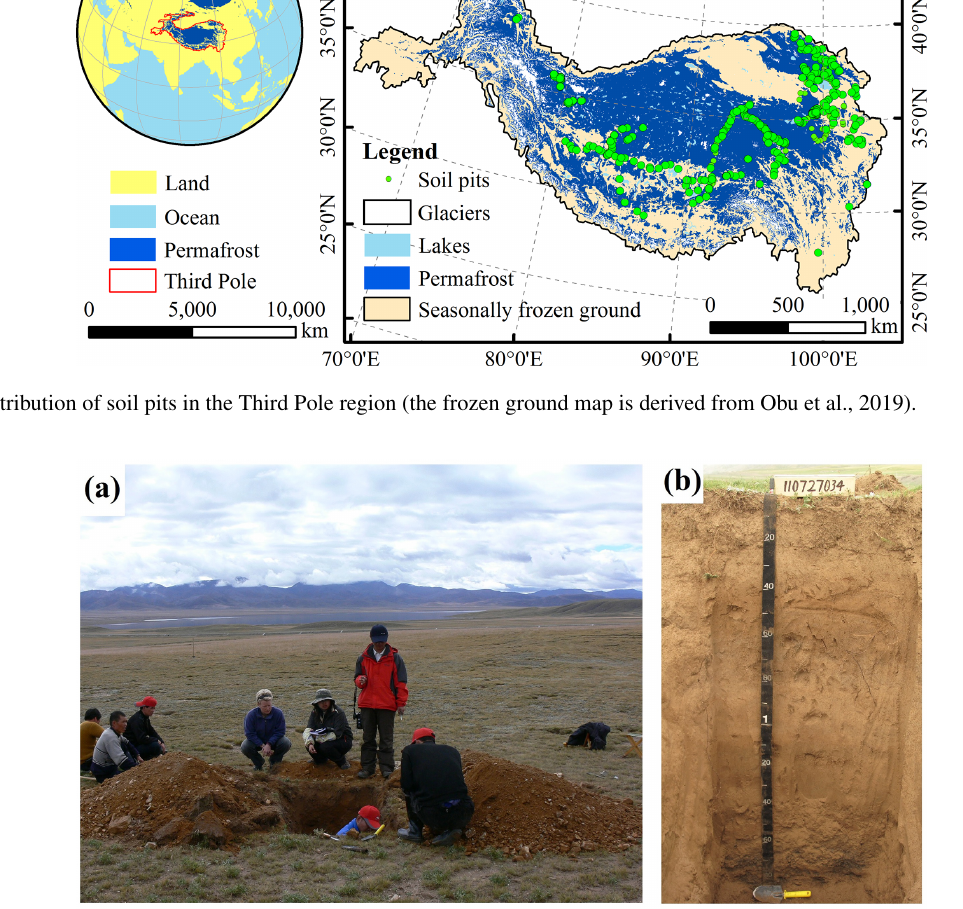
Figure 2. Fieldwork photographs showing (a) soil sample collection and (b) a soil